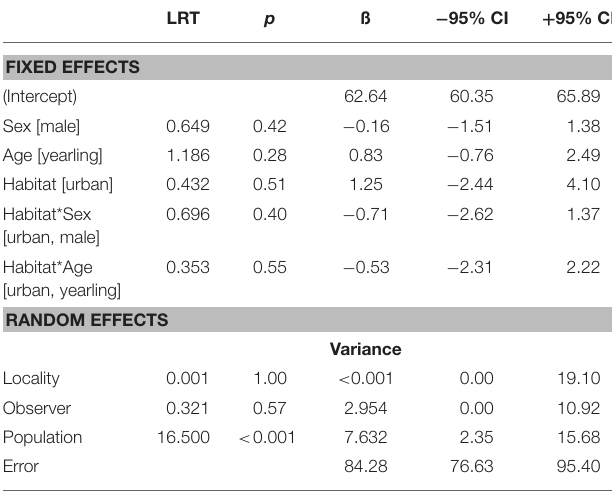
TABLE 6 | Statistical summary of the analysis of breath rate between rural and urban